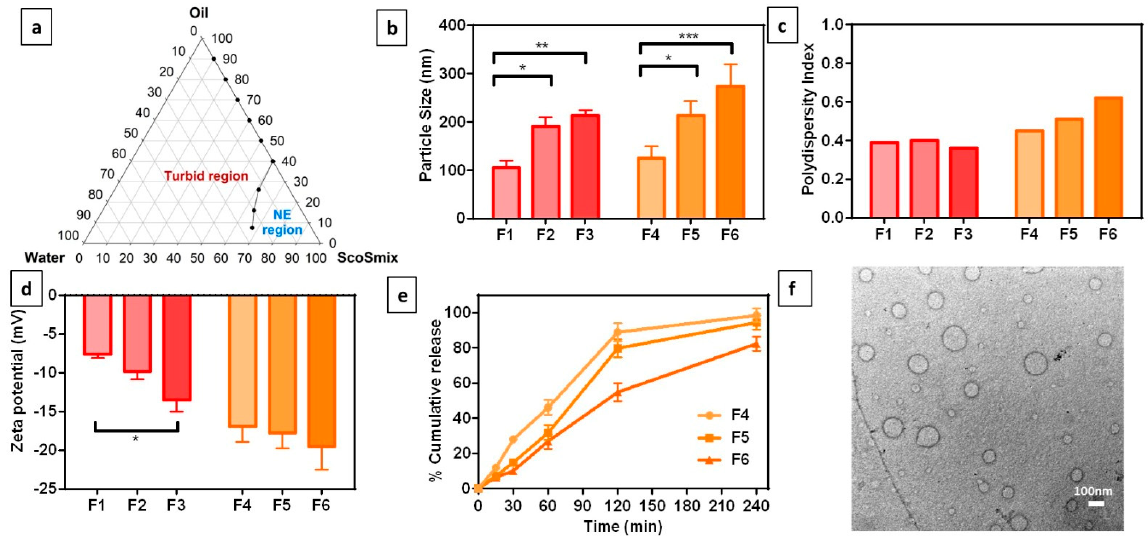
Figure 1. Development of Hypericum perforatum L. nanoemulsion (HP.NE): ( a ) Ternary phase diagram represents the prepared 9 screening trials where the borderline separates the NE region. ( b ) Globule size, ( c ) polydispersity index, and ( d ) surface charge of unloaded (F1-3) and loaded (F4-6) selected NEs. ( e ) The in-vitro release profile of loaded NEs. ( f ) TEM image of F4 as the selected formulation for further investigations. * means significant at p < 0.05; **, significant at p < 0.01; ***, significant at p < 0.001).